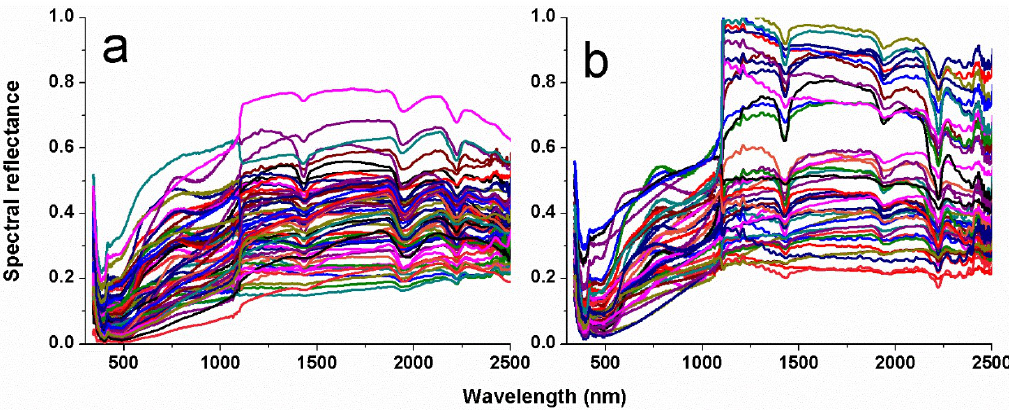
Figure 3. The spectral reflectance curves of ( a ) 65 moisture soil samples and ( b ) corresponding dry soil samples.